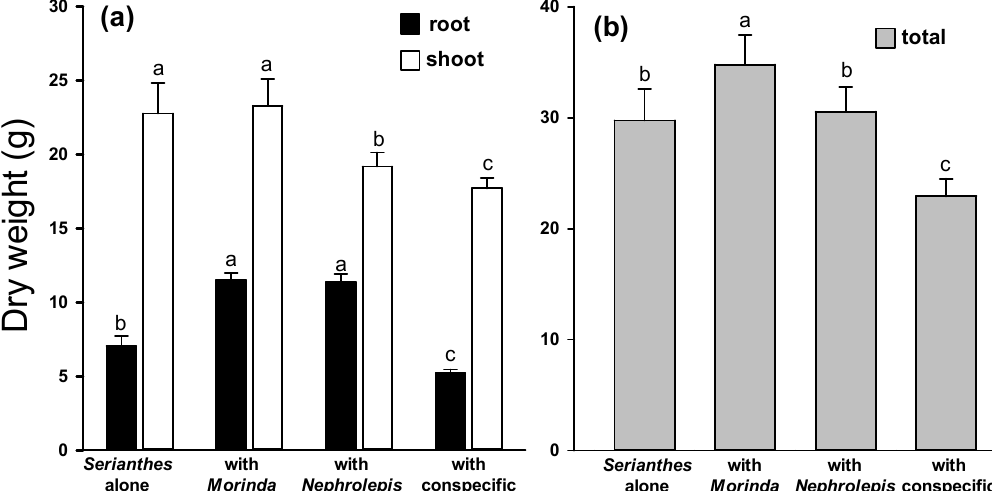
Figure 1. ( a ) Dry weight of roots (black bars) and shoots (white bars) and ( b ) Dry weight of total plant of Serianthes grandiflora seedlings grown with different species. Treatments were: Control, no companion; Morinda citrifolia; Nephrolepis hirsutula ; Conspecific. Bars represent one SE ( n = 8) and bars with the same letters are not significantly different.